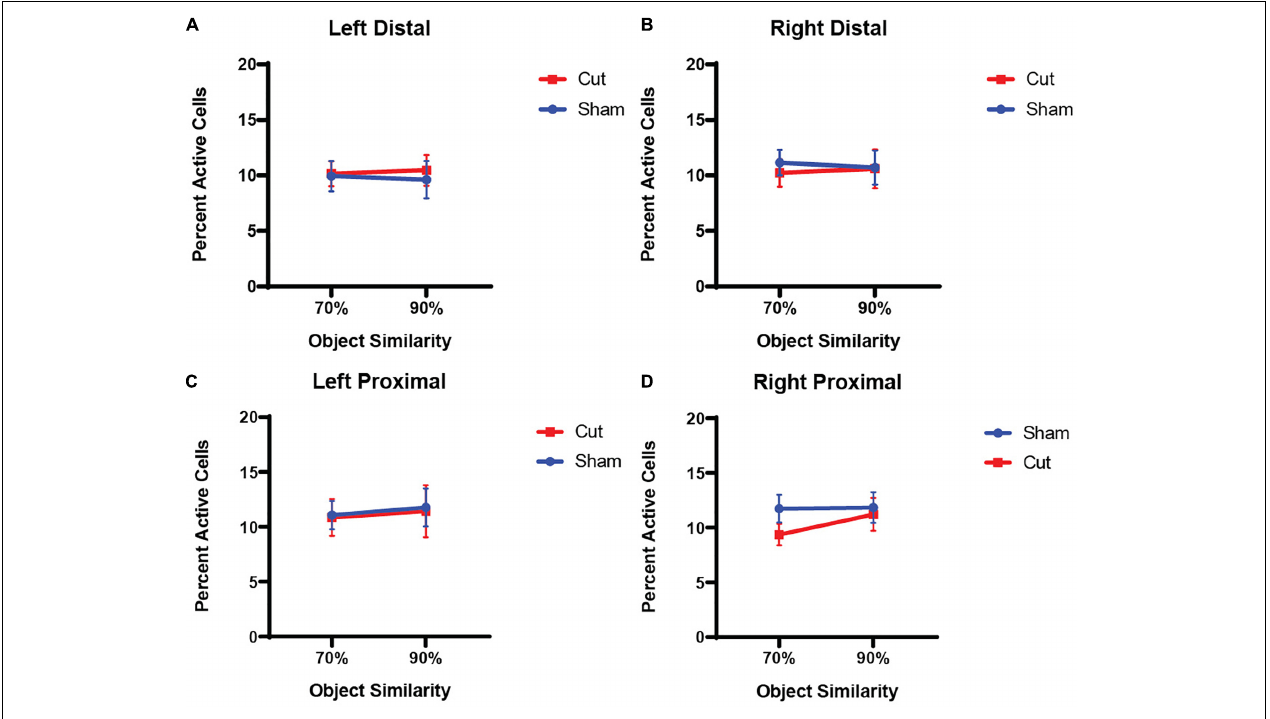
FIGURE 4 | Percentage of active cells, as determined by expression of the immediate early gene Arc , in the CA3 subregion of the hippocampus (n’s: Sham =